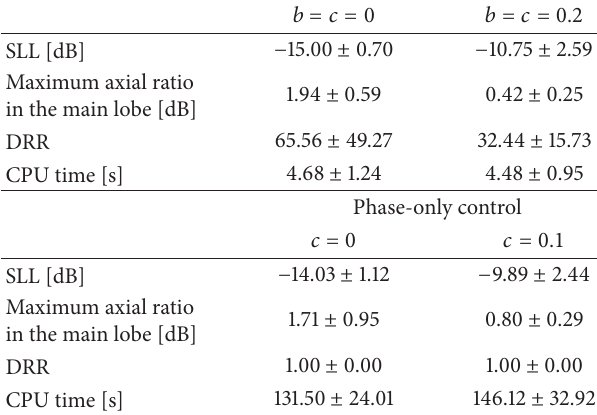
Table 3: Results obtained for the two-dimensional scanning of the region [80 ∘ , 100 ∘ ] × [80 ∘ , 100 ∘